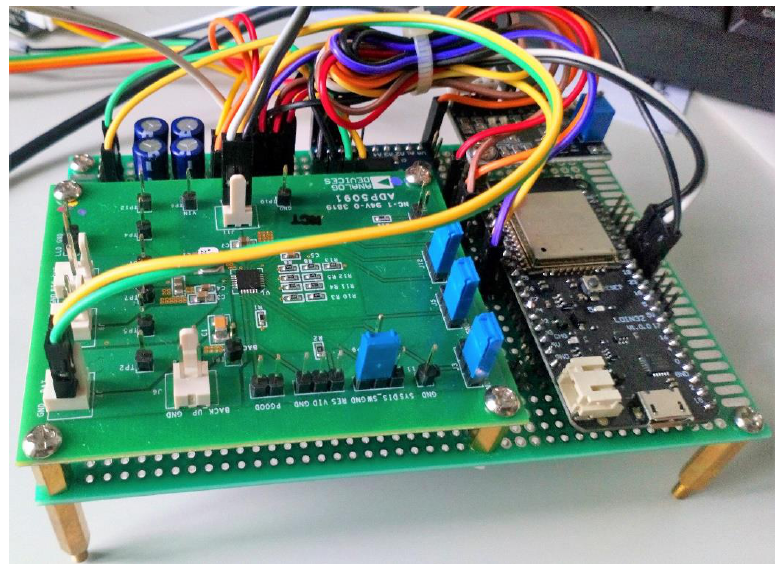
Figure 8. The complete prototype of TE-PV HEH device.